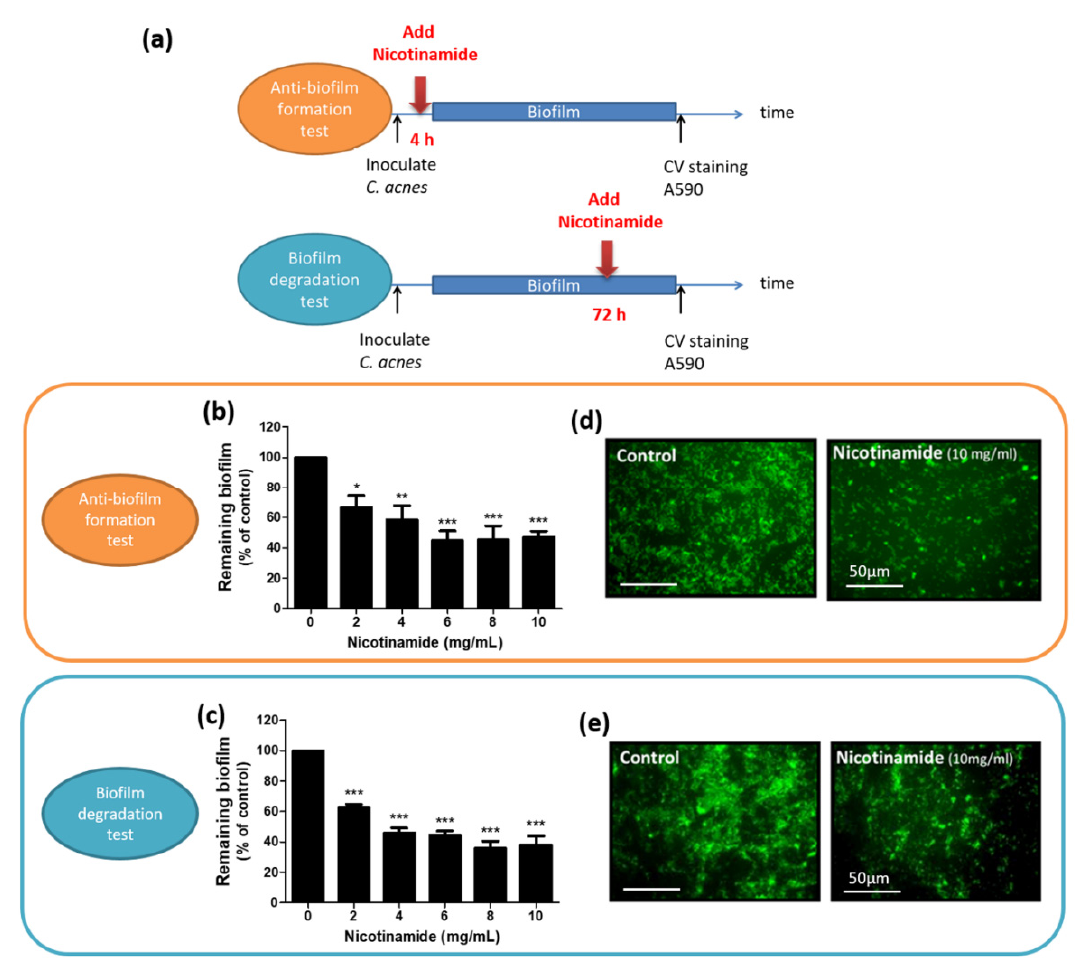
Figure 3. Nicotinamide (NAM) alone inhibits the biofilm of Cutibacterium ( C .) acnes in vitro. ( a ) Scheme showing the design of the antibiofilm formation test and biofilm degradation test used in our study. ( b , c ) NAM was added to the biofilm at the indicated time post-inoculation of C. acnes to better evaluate the effect at specific stages of biofilm development. ( b ) The effect of NAM against biofilms of C. acnes shown by the antibiofilm formation test. n = 3 (mean ± SEM, * p < 0.05, ** p < 0.01, *** p < 0.001). ( c ) The breakdown of preformed biofilms by NAM in the biofilm degradation test. n = 3 (mean ± SEM, * p < 0.05, ** p < 0.01, *** p < 0.001). ( d , e ) To visualize the biofilm, the remaining biofilm was stained with FITC and observed under fluorescence microscopy. ( d ) Representative images of fluorescence microscopy of the antibiofilm formation test. Original magnification, 600x. Scale bar = 50 μ m. ( e ) Representative images of fluorescence microscopy of the biofilm degradation test. Original magnification, 600x. Scale bar = 50 μ m.